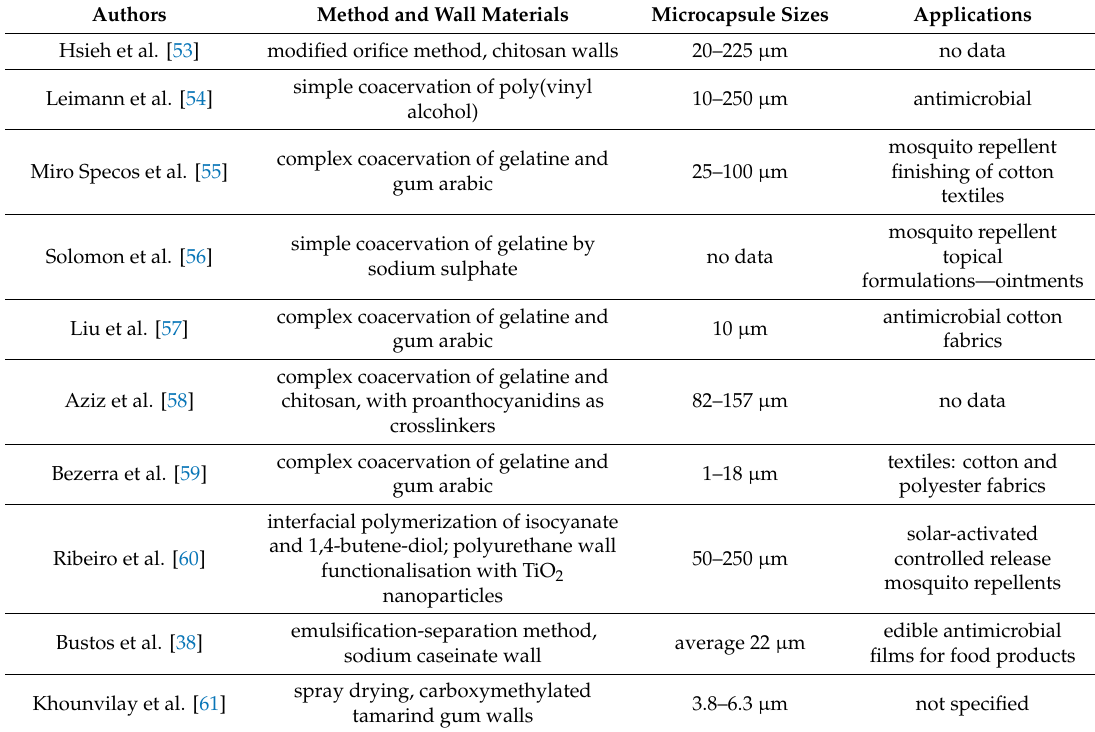
Table 2. Review of citronella oil microencapsulation methods with suggested